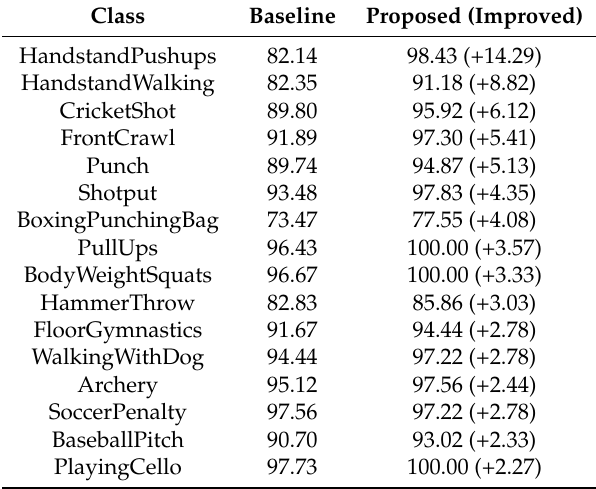
Table 3. The result of the UCF-101 dataset class accuracy of the baseline (I3D using RGB and optical flow) and proposed